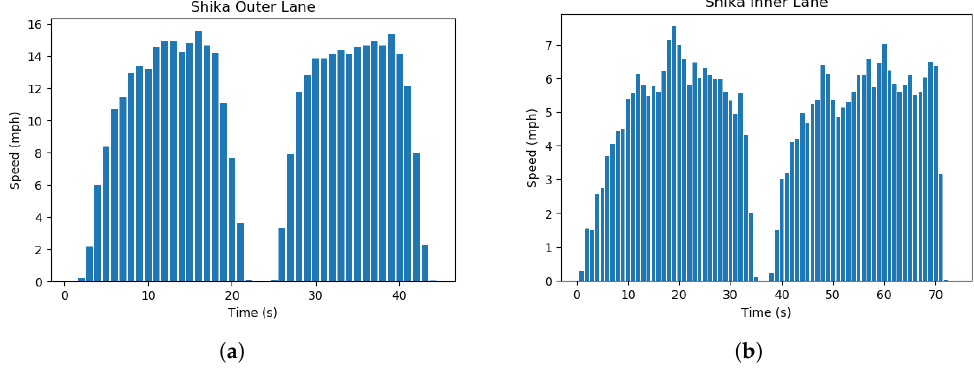
Figure A7. Author Shika Rao’s driving graphs for outer and inner